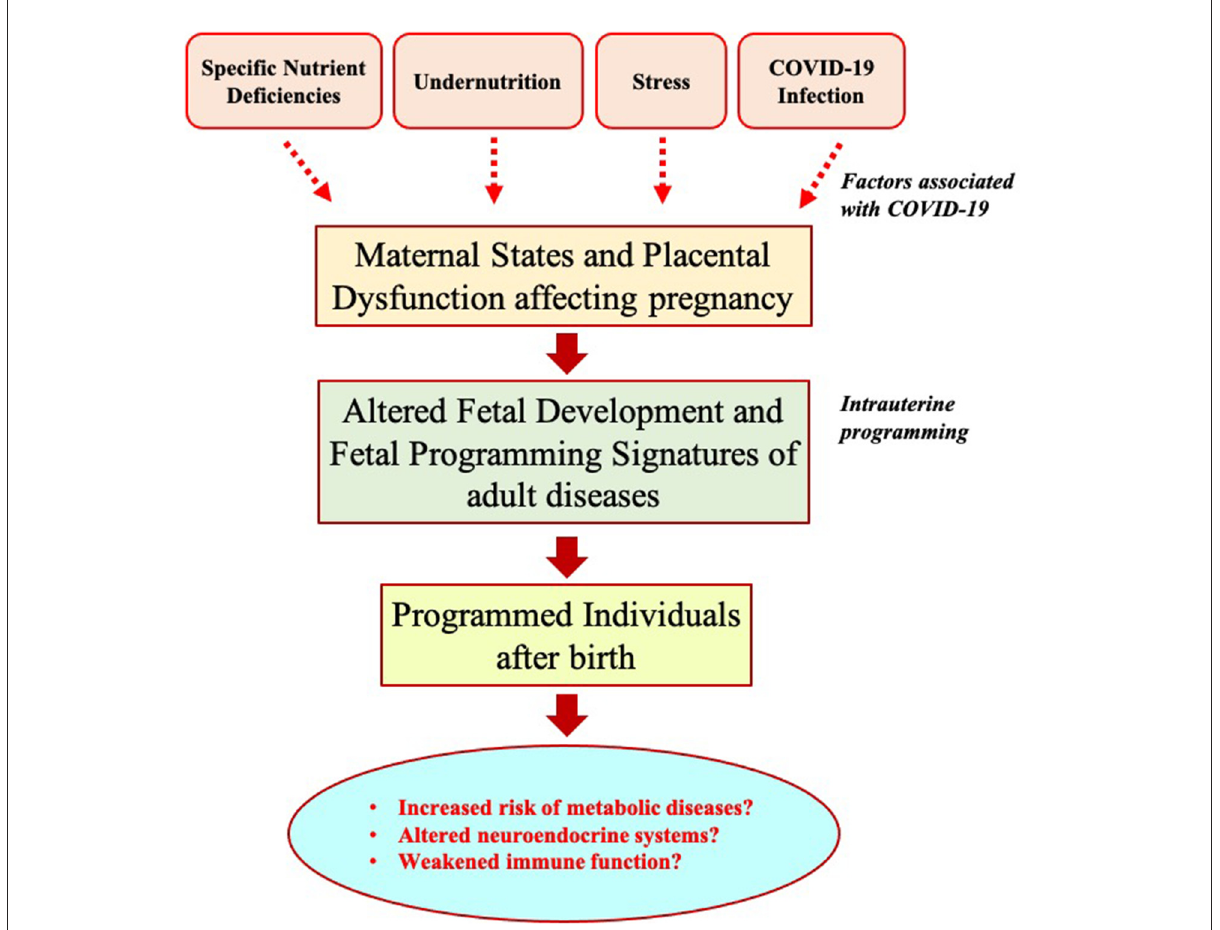
FIGURE1 Potential influences of COVID-19 pandemic on long-term intrauterine programming